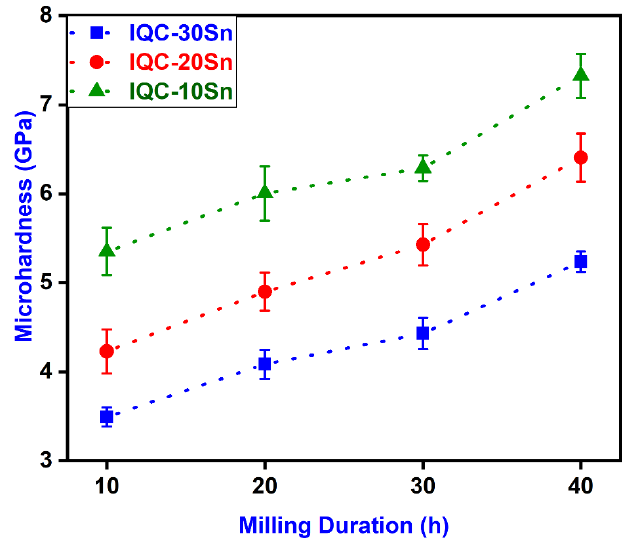
Figure 3. Microhardness (at an indentation load of 10 g) of IQC-Sn nanocomposite powders as a function of the duration of mechanical milling. The optical micrographs of Figure 4 show the indentation marks of the 20 h and 40 h MM powders of IQC-10Sn, IQC-20 Sn, and IQC-30Sn. It can be discerned from Figure 4a– f that the crack length after indentation at a load of 10 g is highest for IQC-10Sn, followed by IQC-20Sn and 30Sn. The inhibition of cracks during indentation varies as a function of the volume fraction of Sn and the duration of MM. Upon increasing the time of MM to 40 h, the crack length of IQC-10Sn, 20Sn and 30Sn after indentation decreases, as shown in Figure 4b,d,f, respectively. After 40 h of MM, no significant marks of indentation cracks were observed for IQC-10Sn, 20Sn and 30Sn nanocomposite powder. However, the case for 20 h MM IQC-Sn nanocomposite powder is not the same. The crack lengths for 20 h MM IQC-10Sn, 20Sn and 30Sn were found to be~11.5 µm, ~6.5 µm, and~4.2 µm, respectively.